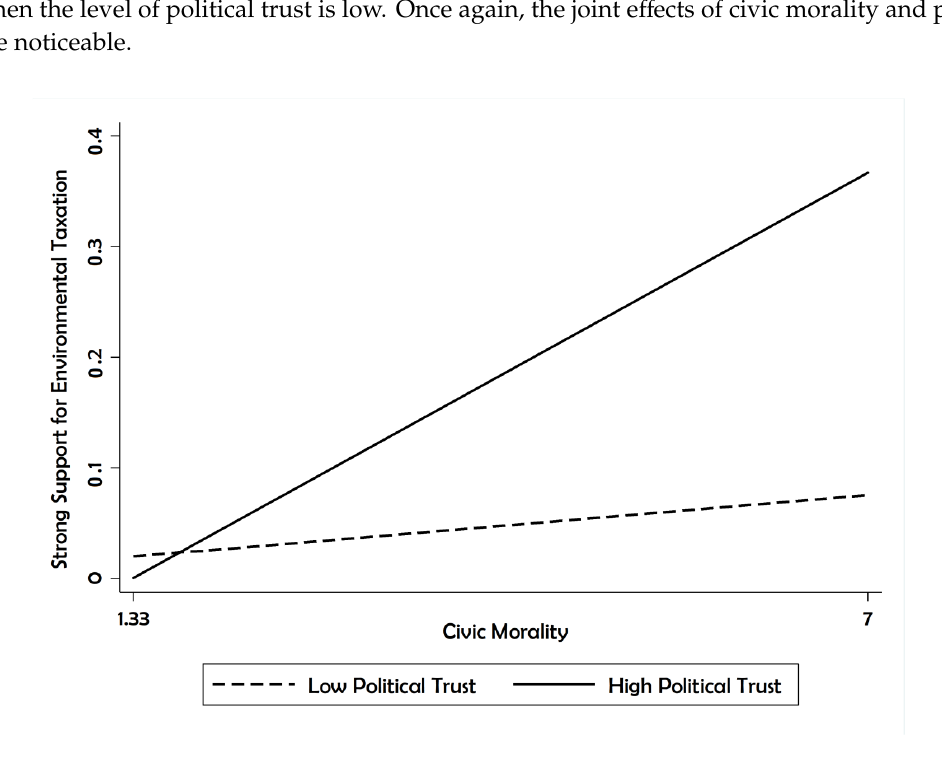
Figure 2. Predicted probabilities of strong support for environmental taxation.